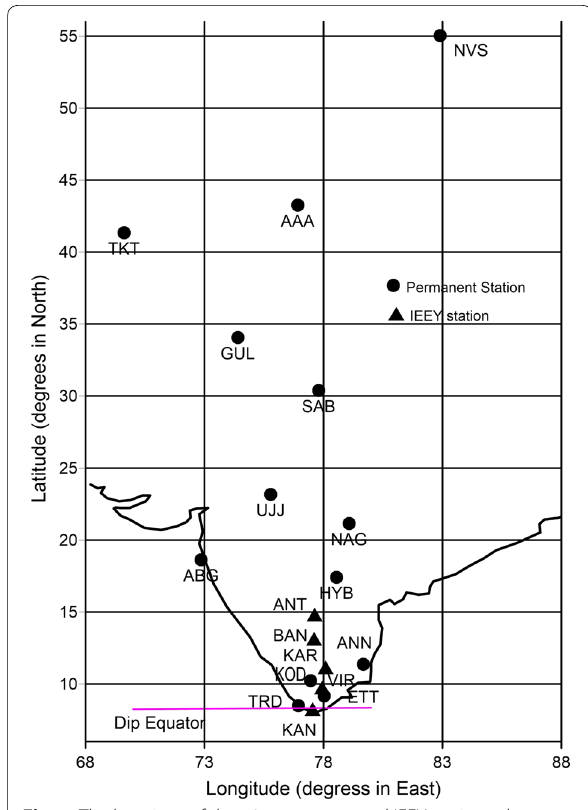
Fig. 1 The locations of the 18 permanent and IEEY stations along with the position of the dip equator for the year 1995. Solid circles denote permanent observatories, and triangles denote IEEY